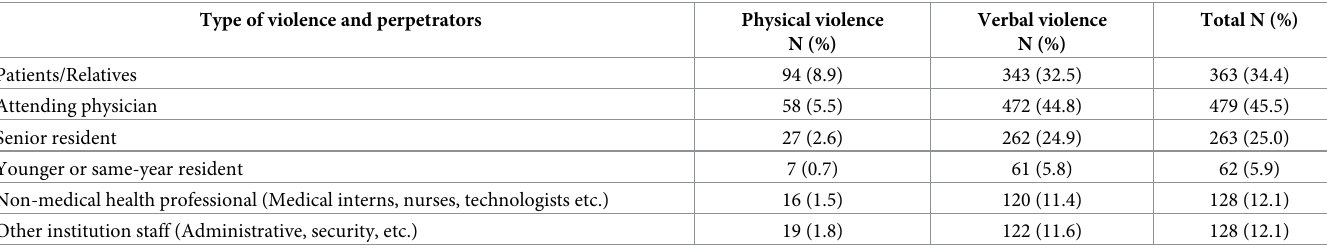
Table 3. Physical and verbal violence according to aggressor (n =